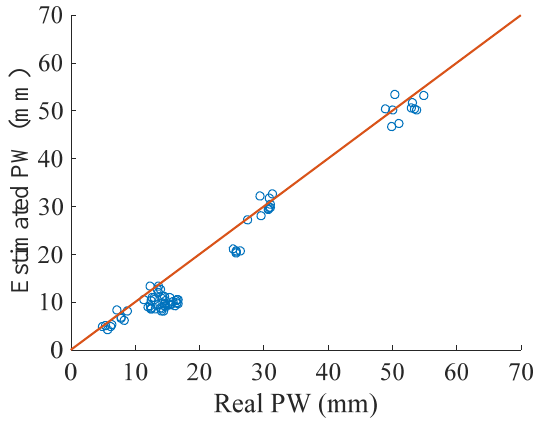
Figure 4. Root mean square error (RMSE) of the estimated PW.